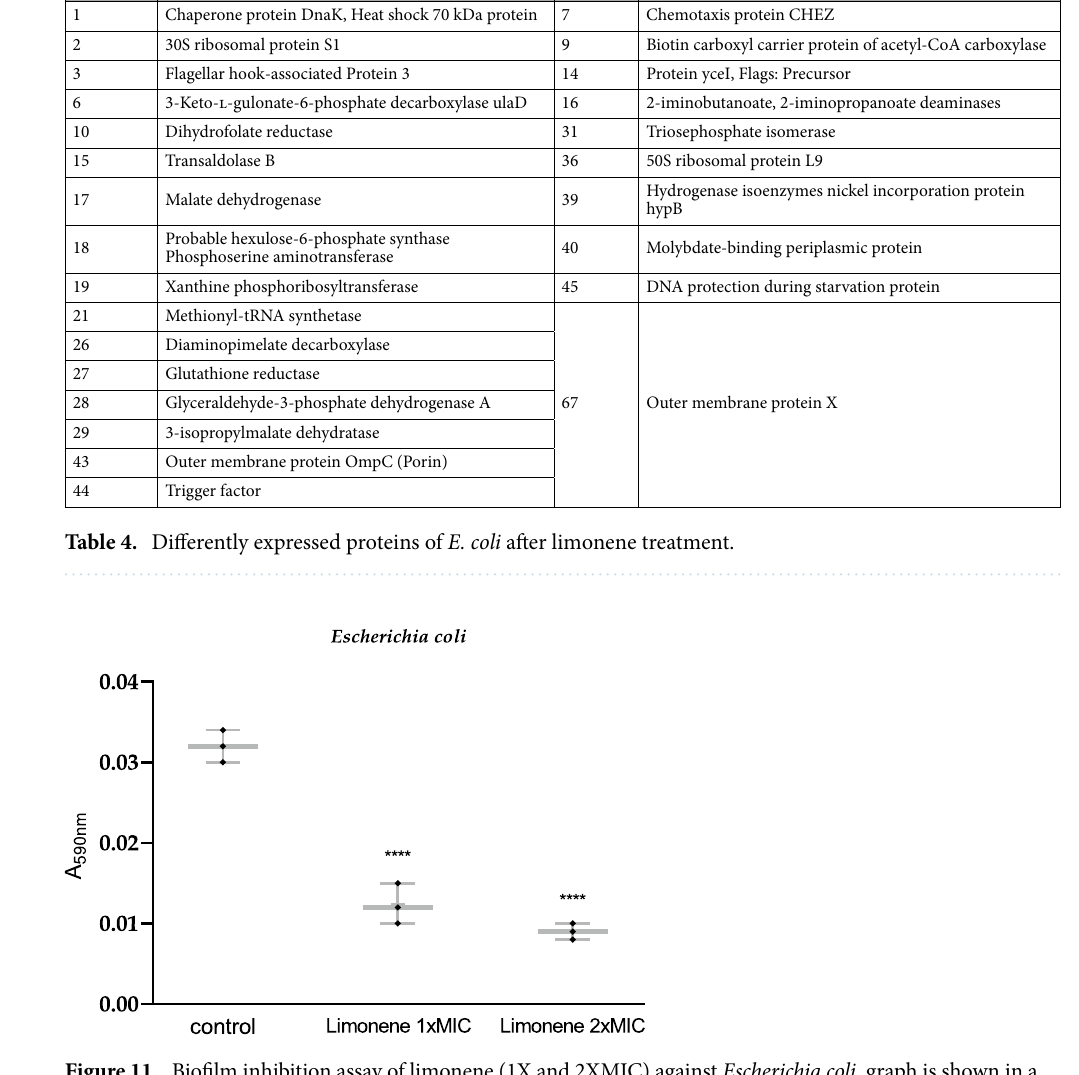
Figure 11. Biofilm inhibition assay of limonene (1X and 2XMIC) against Escherichia coli , graph is shown in a box and whisker format. Boxes range from the minimum to maximum percentile and are intersected by median line. Whiskers extending below and above the box range from 1st to 90th percentile, respectively. All data points are also indicated